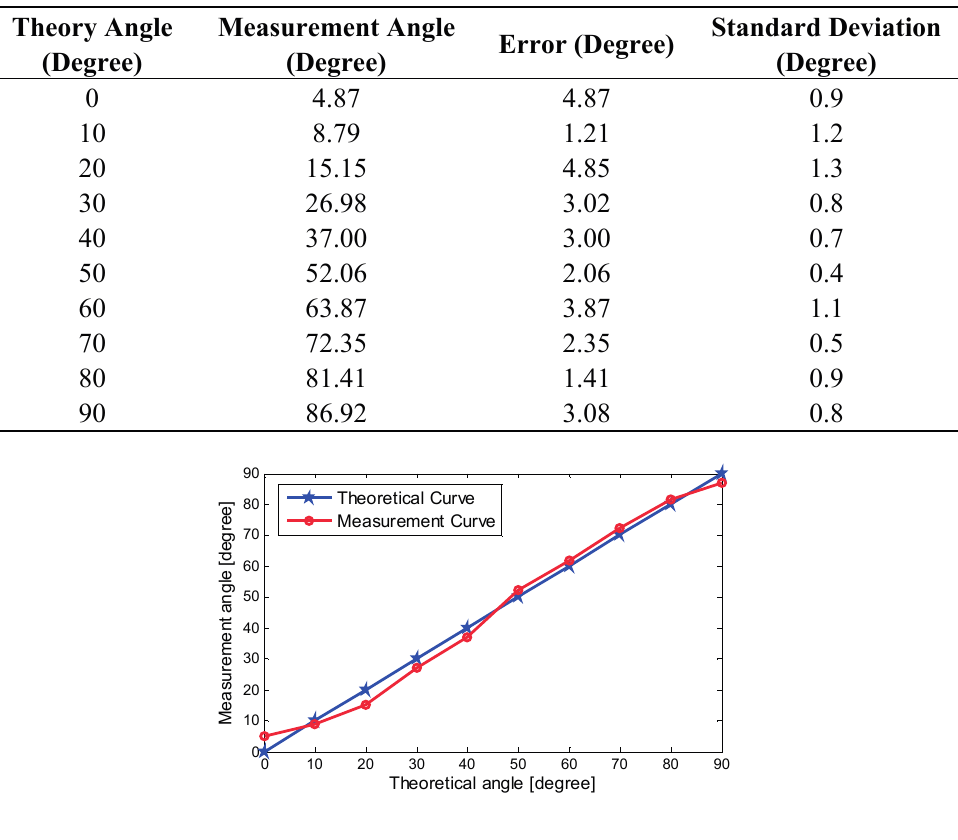
Figure 14. Correlation curve of practical angle and theoretical